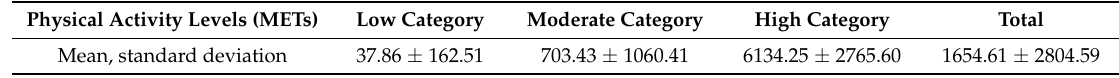
Table 2. Physical activity levels among participants (n =